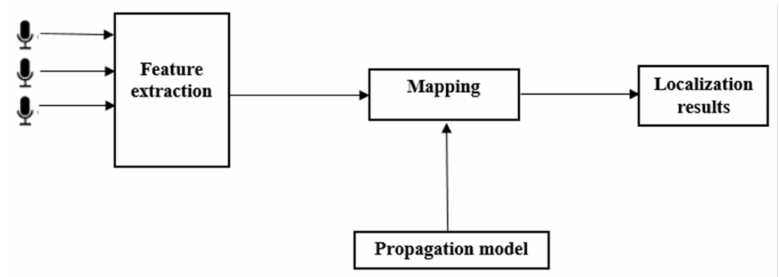
Figure 2. Basic concept of sound